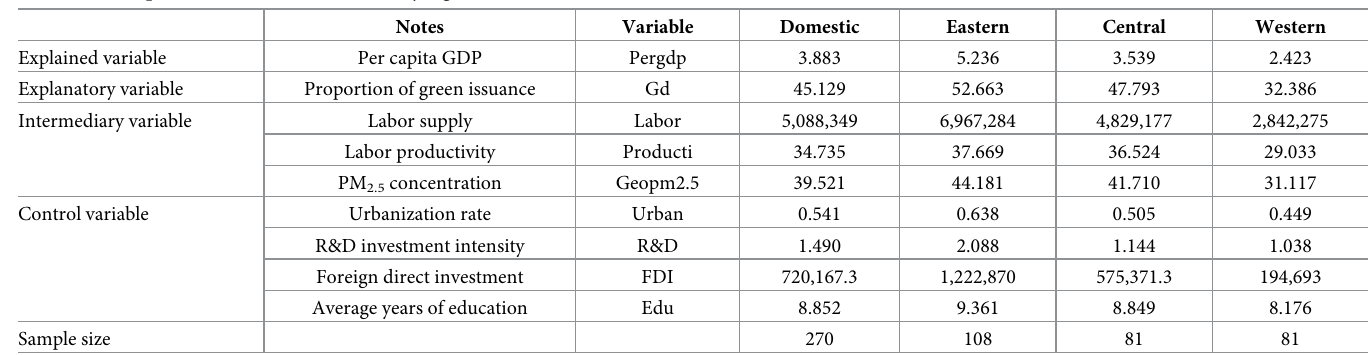
Table 1. Descriptive statistics of each variable by